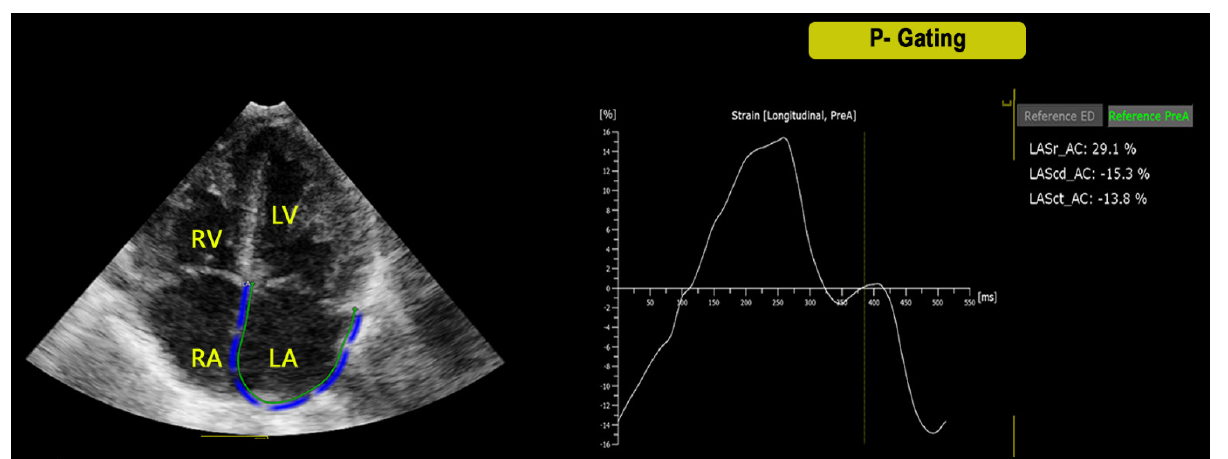
min = minutes; LVPO = Left Ventricle Pressure Overload; LVVO = Left Ventricle Volume Overload; RVPO = Right Ventricle Pressure Overload; RVVO = Right Ventricle Volume Overload; TGA = transposition of the great arteries; STAT-score = Society of Thoracic Surgeons/European Association of Cardio-Thoracic Surgery-STS/EACTS. § 1 tamponed, ◦ 1 tamponed, 1 Av block, * 1 AV block, 2 diaphragmatic paralyses.